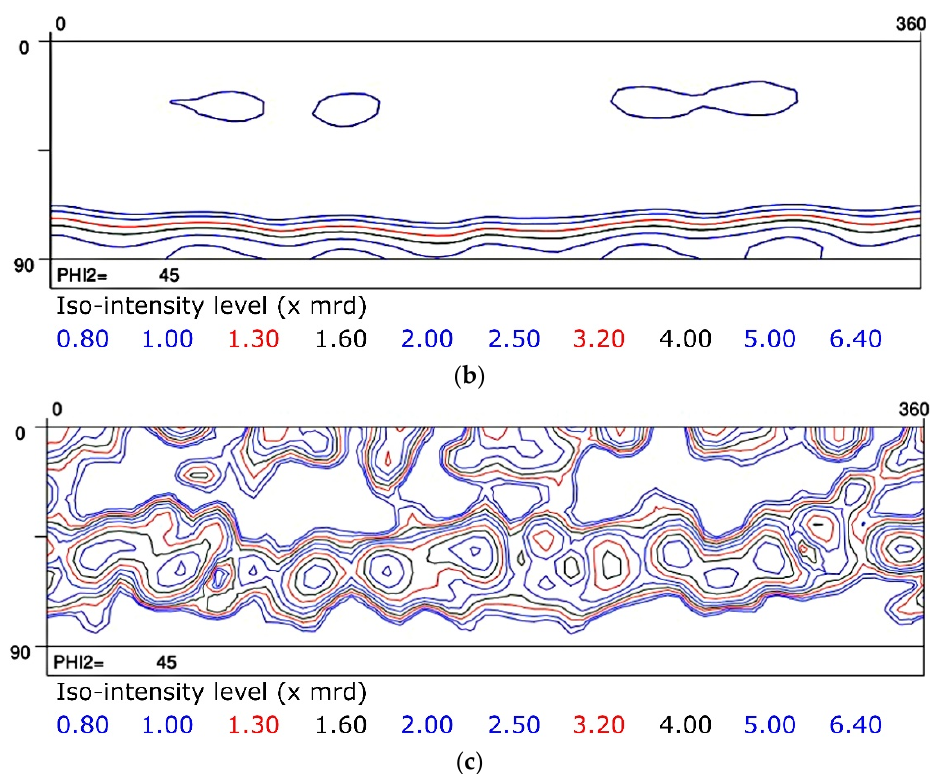
Figure 4. ( a ) Typical {111} deep drawing texture of an IF steel grade; ( b ) FCC texture derived from ( a ) by applying the YKS orientation operator without variant selection; ( c ) BCC texture derived by applying the double YKS variant selection rule to a sample of discrete orientations representative of the texture shown in ( b ) after random scrambling of the sequence of these orientations.